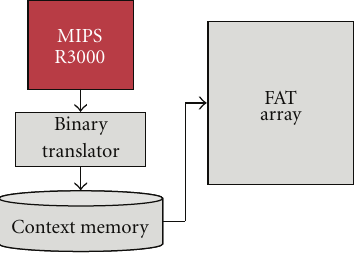
Figure 1: FAT-array system block diagram.